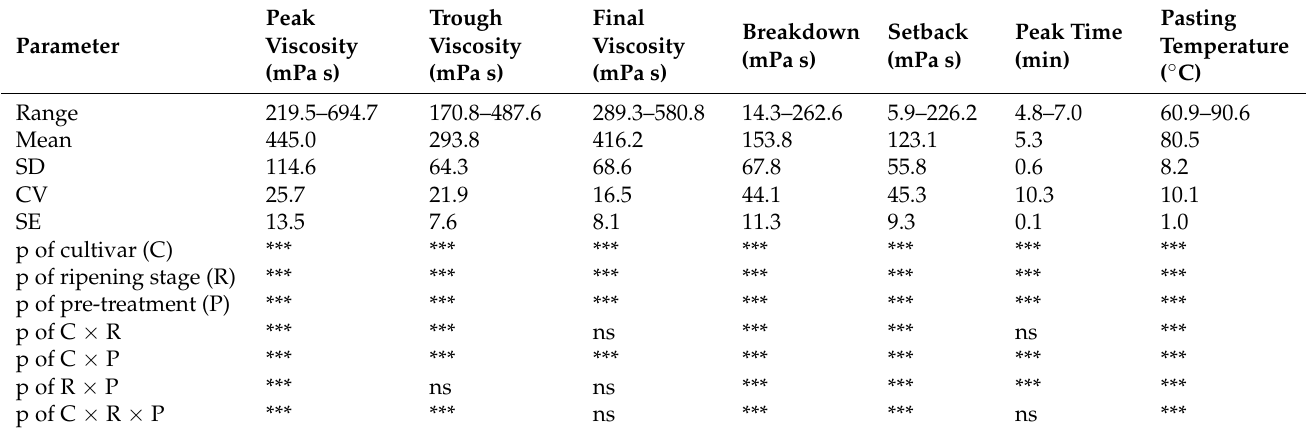
Table 4. ANOVA statistics showing the effect of cultivar, ripening stages, and pre-treatment methods on the pasting properties of plantain